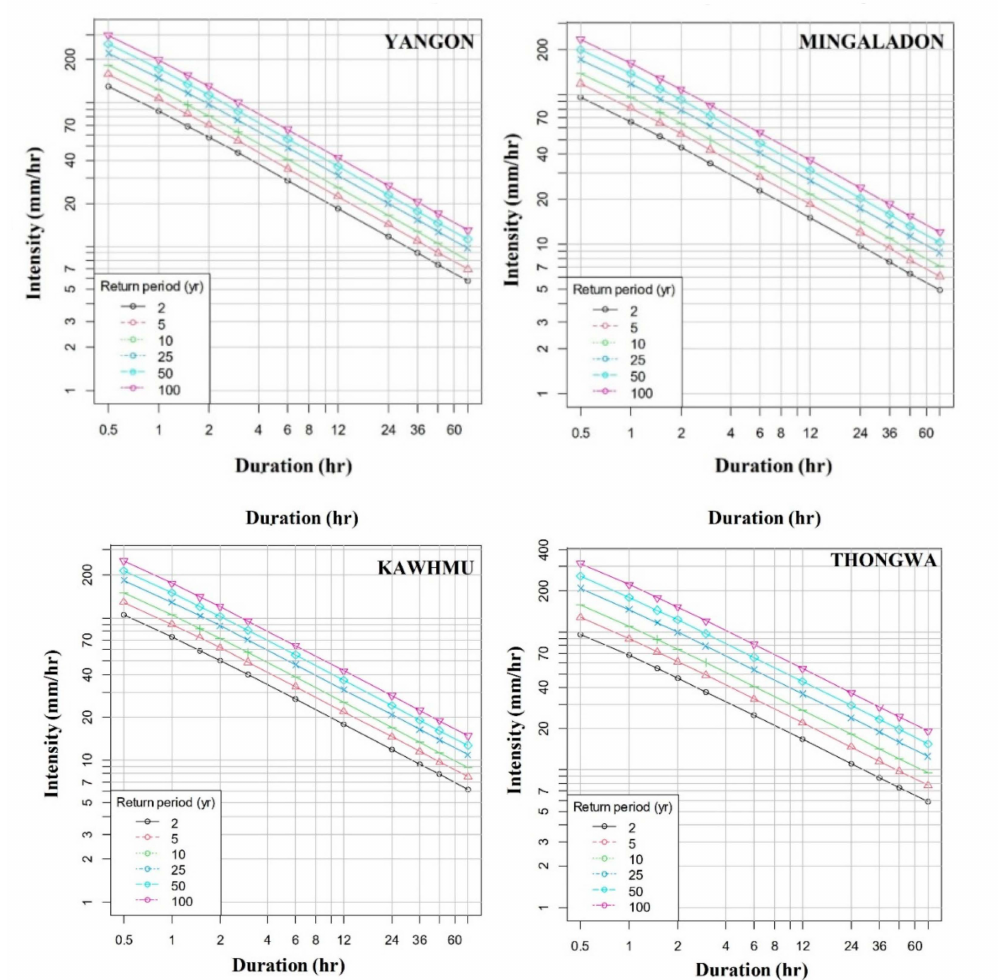
Figure 8. The IMERG bias-corrected IDF curves at four study locations of